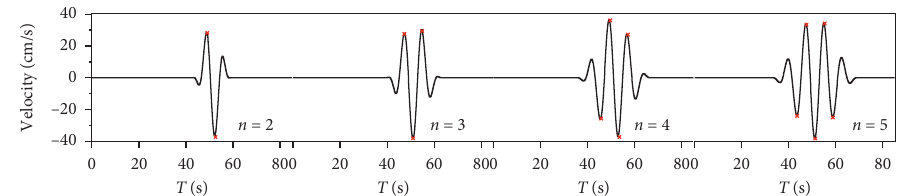
Figure 21: Velocity time-history curves of APTE with different numbers of significant